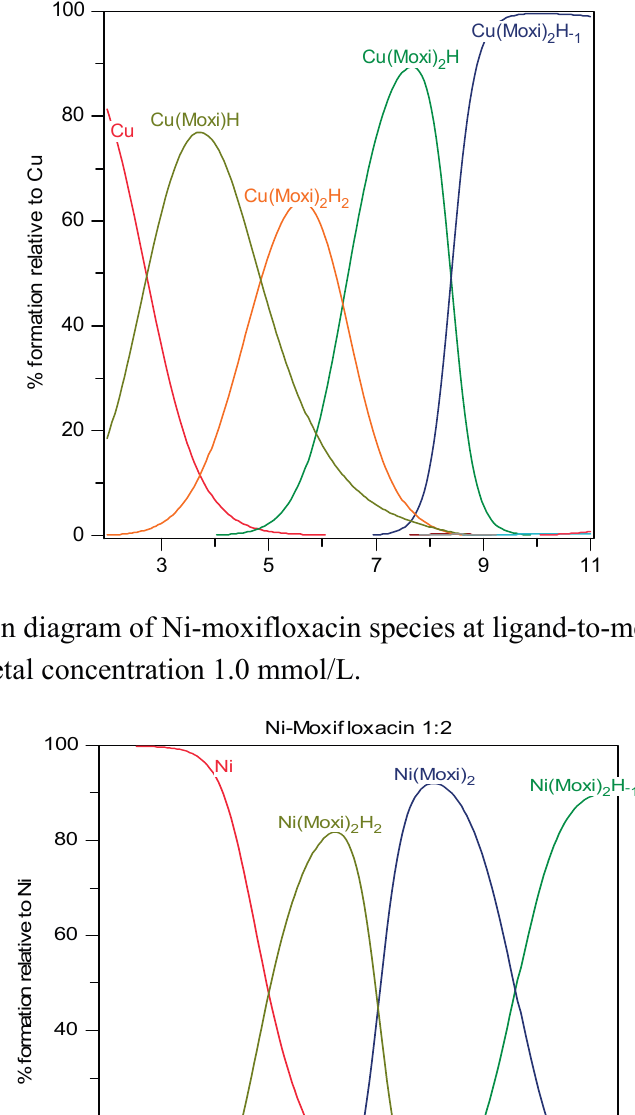
Figure 3. Distribution diagram of Cu-moxifloxacin species at ligand-to-metal concentration ratio 2:1 and total metal concentration 1.0 mmol/L.